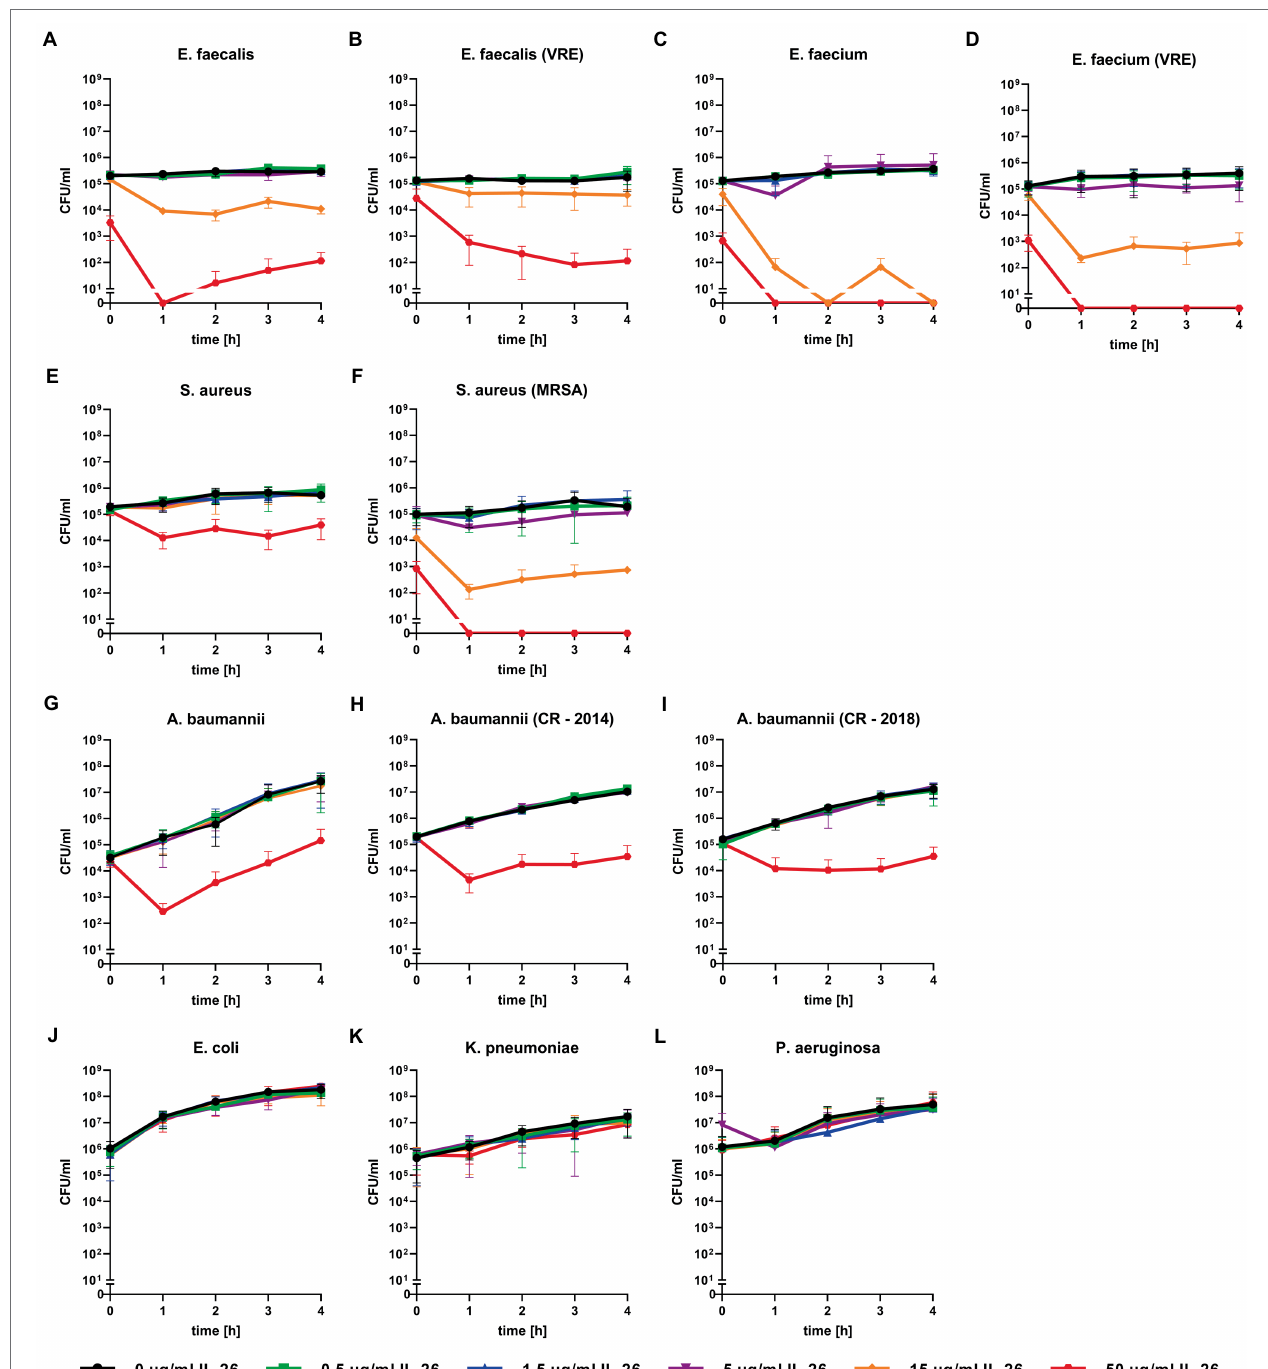
FIGURE 2 | Number of colony forming units per ml of different bacteria over 4 h incubation at different IL-26 concentrations. Panels (A-F) show IL-26 sensitive Gram-positive strains, panels (G-I) show IL-26 sensitive Gram-negative strains, and panels (J-L) show IL-26-resistant Gram-negative strains. Data are given as mean with standard deviation, for each strain n = 3. CFU, colony-forming units; VRE, vancomycin-resistant Enterococcus; MRSA, methicillin-resistant S. aureus ; and CR, carbapenem